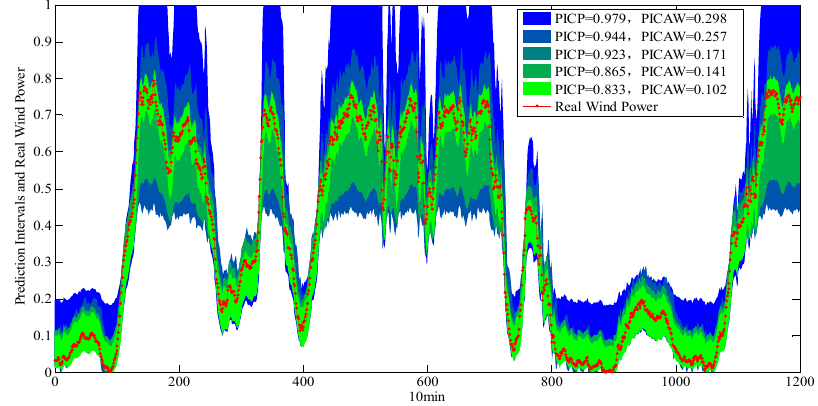
η= η= . CWC: coverage width-based η= . CWC: coverage width-based . CWC: coverage width-based